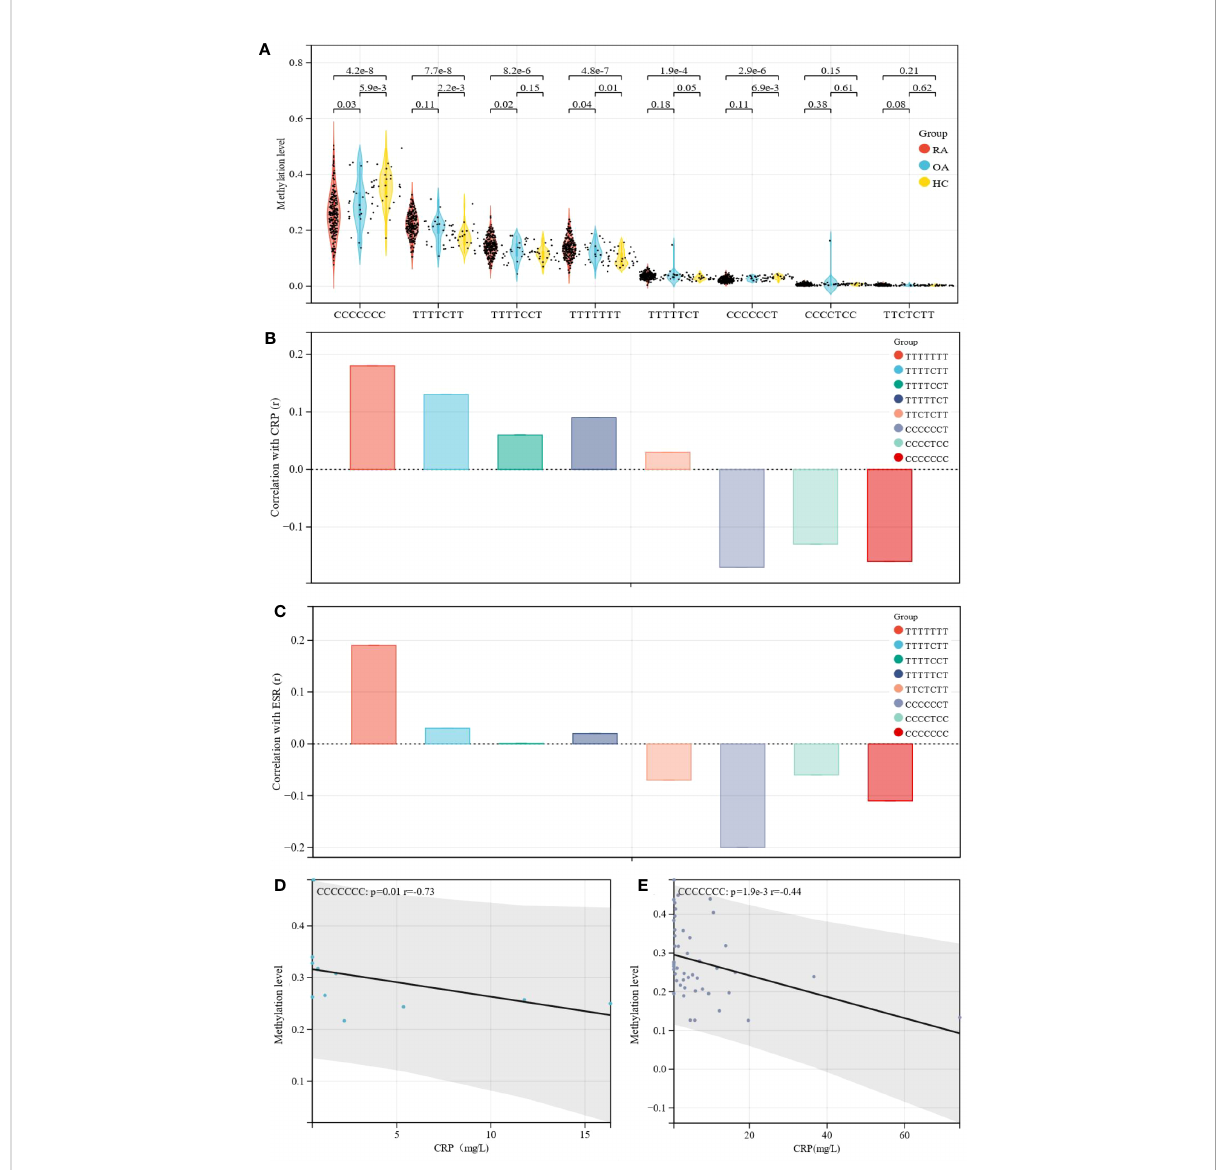
FIGURE 2 Differences in methylation level and correlation of haplotype sites. (A) Methylation level of different haplotype sites between RA, OA patients and healthy controls; Further analysis showed that HIPK3 has eight haplothpe sites, including TTTTTTT, TTTTCTT, TTTTCCT, TTTTTCT, TTCTCTT, CCCCCCT, CCCCTCC, CCCCCCC; The difference analysis showed that the methylation levels of these haplotype sites in patients with RA were different regulated, and among them, the methylation level of CCCCCCC in RA showed a downward trend, and the statistical difference was the most signi fi cant. (B) Correlation of haplotype sites with CRP were different compared with TTTTTTT; The correlation between different haplotype sites and CRP was analyzed, and the results were compared with TTTTTTT; Taking TTTTTTT as the standard, the trend of correlation between different haplotype sites and CRP was shown. (C) Correlation of haplotype sites with ESR was different compared with TTTTTTT; The correlation between different haplotype sites and ESR was analyzed, and the results were compared with TTTTTTT; Taking TTTTTTT as the standard, the trend of correlation between different haplotype sites and ESR was shown. (D) In patients with RF (-)/ACPA (-), CCCCCCC was negatively correlated with CRP; Further analysis of the correlation between haplotype sites and clinical indexes in different subgroups; The results showed that in patients with RF (-)/ACPA (-), correlation between CCCCCCC and CRP was the highest and the P value was statistically signi fi cant; CCCCCCC was negatively correlated with CRP level (r= -0.73, p= 0.01). (E) In patients with 2.6 ≤ DAS28-CRP ≤ 3.2, CCCCCCC were negatively correlated with CRP; Similarly, subgroup analysis also found that In patients with 2.6 ≤ DAS28-CRP ≤ 3.2, there was also a statistically signi fi cant negative correlation trend between CCCCCCC and CRP (r= -0.44, p= 0.0019), and which was helpful to judge the change trend of clinical CRP